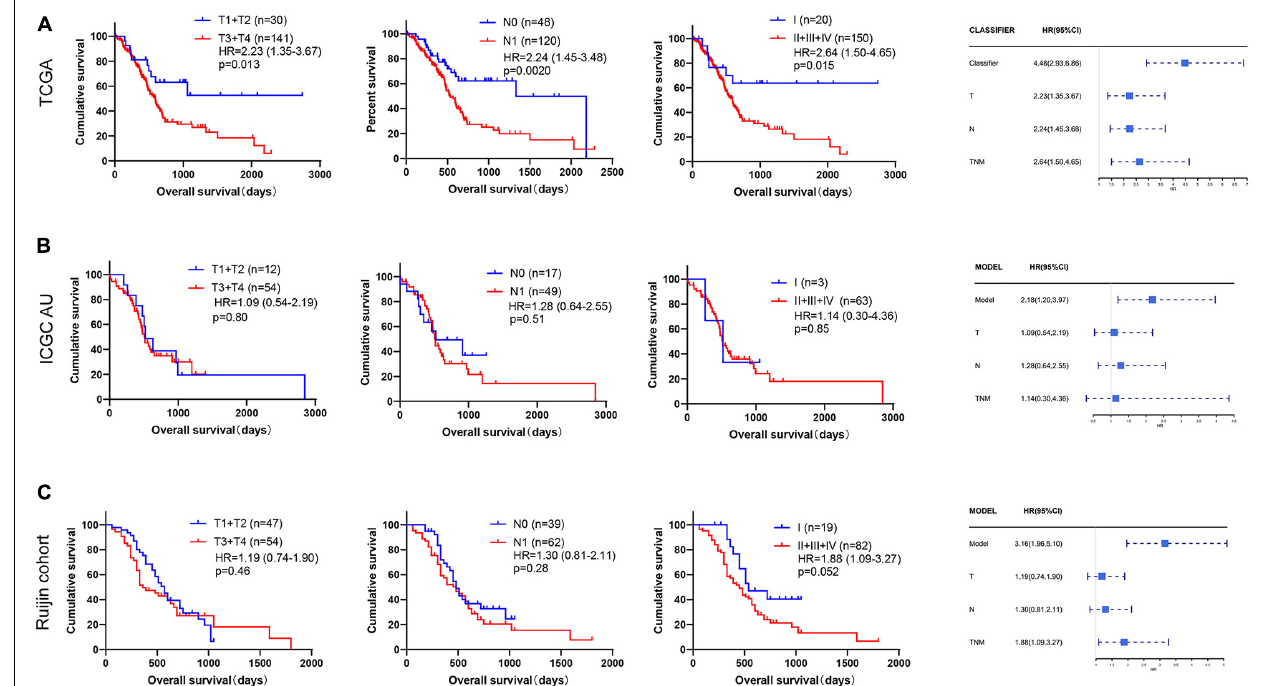
log-rank test was used to assess intergroup differences.